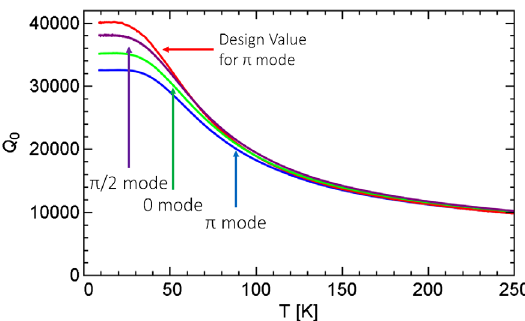
FIG. 8. Measured Q 0 versus temperature for the three modes of Cryo-Cu-SLAC-#2, and the design value for the π mode.